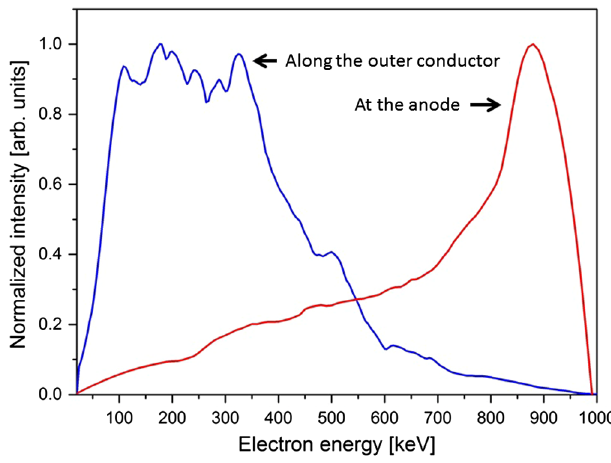
FIG. 13. Comparison of the electron energy distribution of the loss electrons (in blue) and the electron energy distribution inside the diode